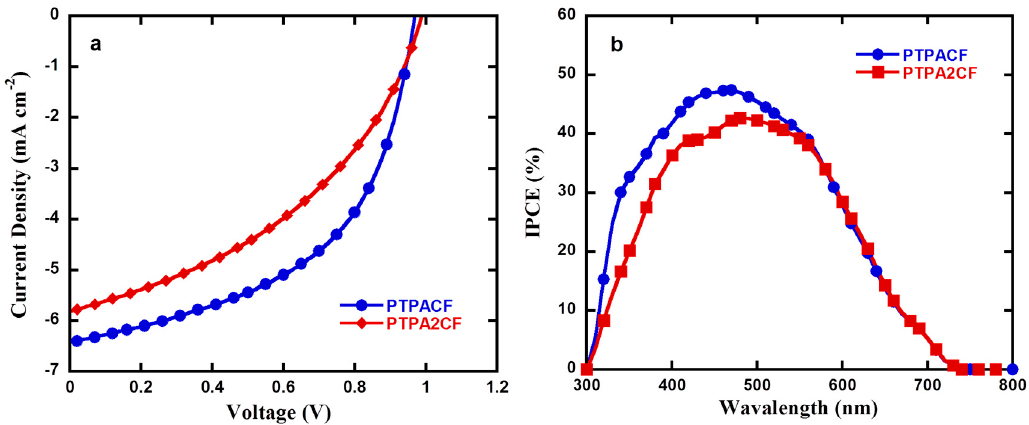
Figure 5. J – V characteristics ( a ) and the corresponding IPCE spectra ( b ) of PTPACF:PC 71 BM and PTPA2CF:PC 71 BM based PSCs, under the illumination of AM1.5G, 100 mW·cm − 2 .